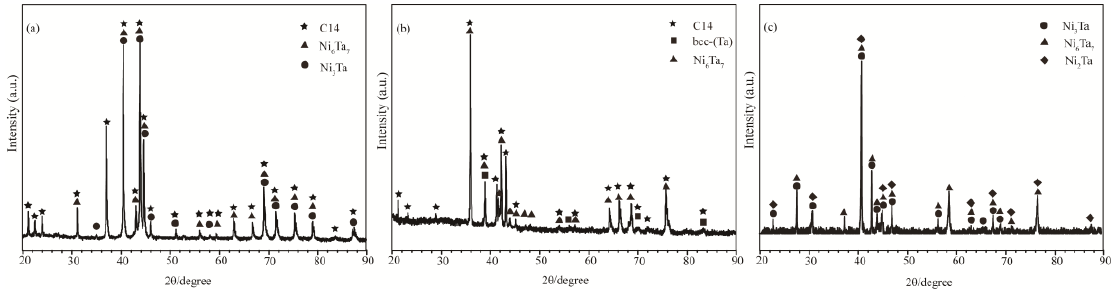
Figure 6. The X-ray diffraction (XRD) patterns of typical alloys in the Ni-V-Ta system annealed at 1200 °C for 40 days. ( a ) Ni 48 V 18 Ta 34 ; ( b ) Ni 14 V 36 Ta 50 ; ( c ) Ni 64 V 5 Ta 31 .